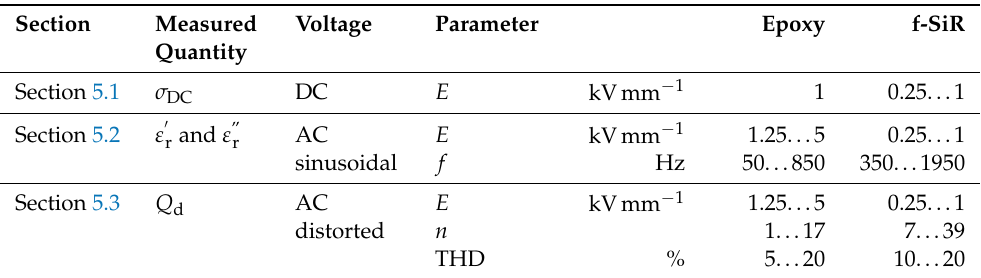
Table 2. Overview of the